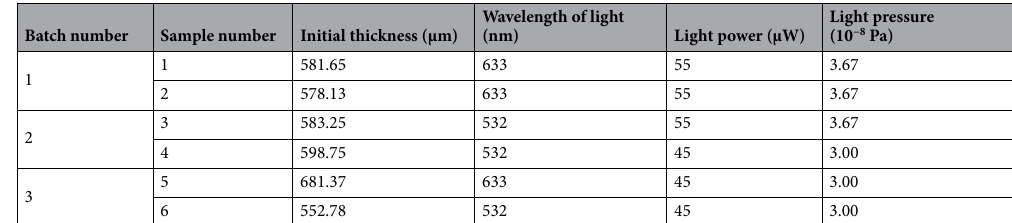
Batch number Sample number Initial thickness (µm)